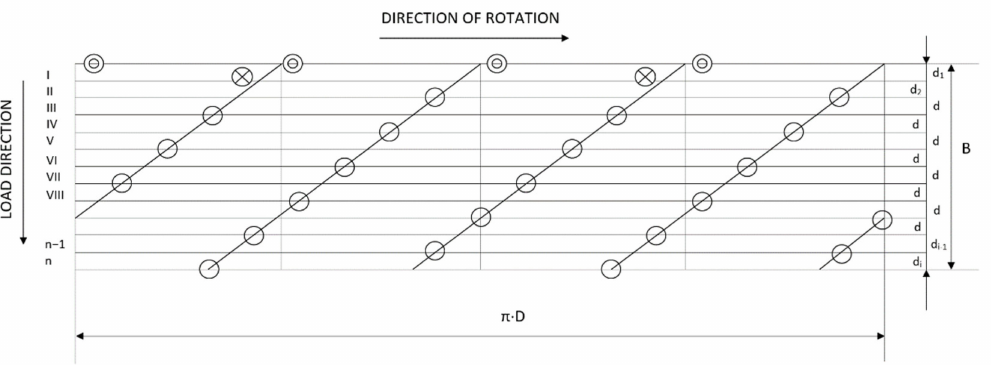
Figure 11. Scheme of principle for placing the shearer picks on the cutter drum: (D) outside diameter of the cutter drum; (B) width of the stripe being